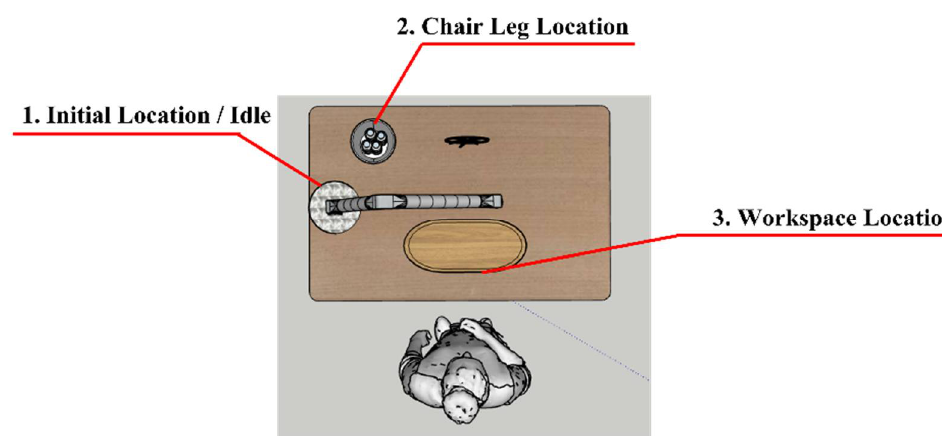
Figure 14. Trajectory Plan.